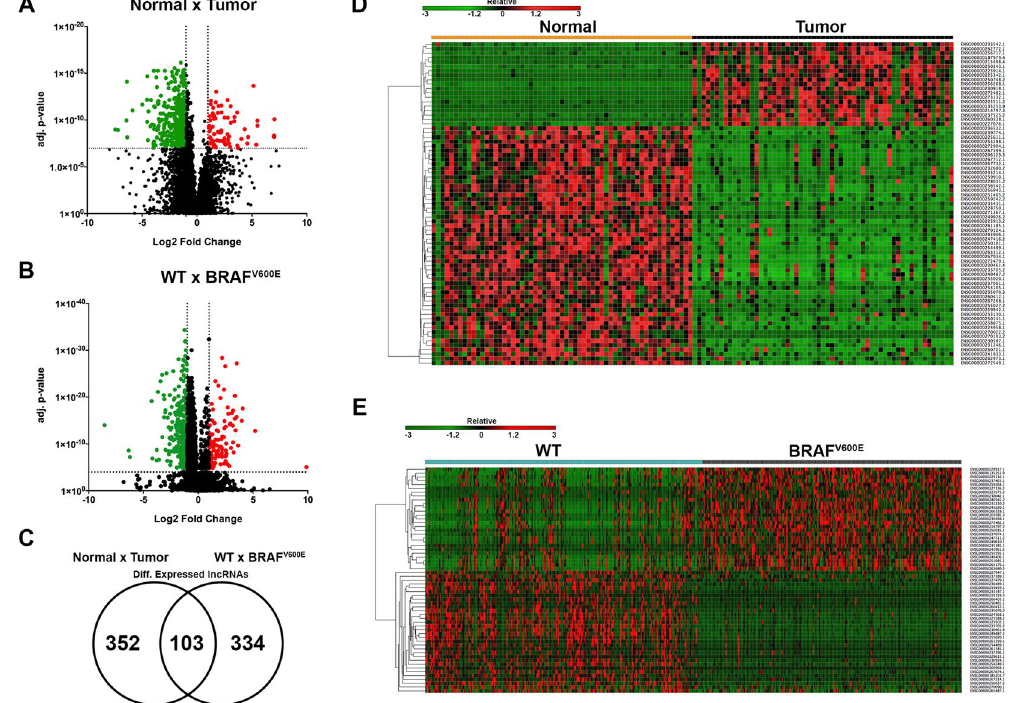
Figure 1. Differentially expressed lncRNAs between N × T and WT × BRAF V600E were identified. ( A ) Volcano plot of DE lncRNAs between N × T (log2 fold change > 1 or < − 1; adj. p-value < 1 × 10 − 7 ). ( B ) Volcano plot of DE lncRNAs between WT × BRAF V600E (log2 fold change > 1 or < − 1; adj. p-value < 1 × 10 − 4 ). ( C ) Venn Diagram of common DE lncRNAs between N × T and WT × BRAF V600E . ( D ) Heatmap * of DE lncRNAs between N × T (log2 fold change > 3 or < − 3; adj. p-value < 1 × 10 − 7 ). ( E ) Heatmap * of DE lncRNAs between WT × BRAF V600E (log2 fold change > 2.5 or < − 2.5; adj. p-value < 1 × 10 − 4 ). * For hierarchical clustering, one minus Spearman rank correlation was performed.